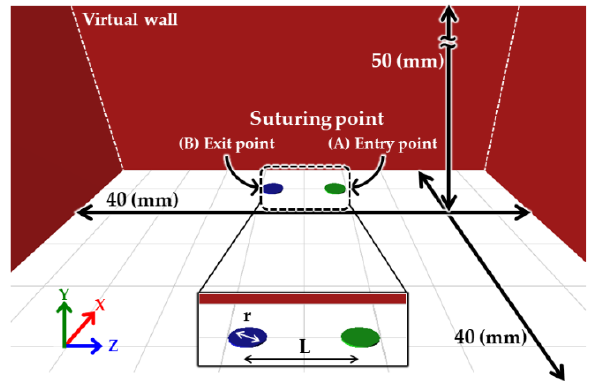
Figure 2. Experimental conditions of the virtual environment.